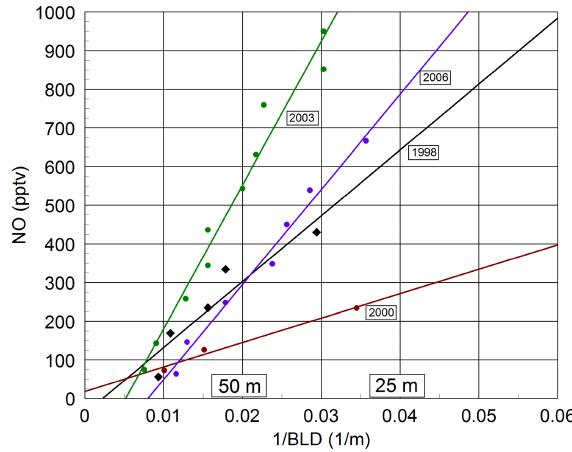
Figure 11. NO vs. 1 / BLD for BLD averaged for each 100pptv bin of NO. r 2 is as follows: 1998: 0.88; 2000: 0.98; 2003:0.97; and 2006: